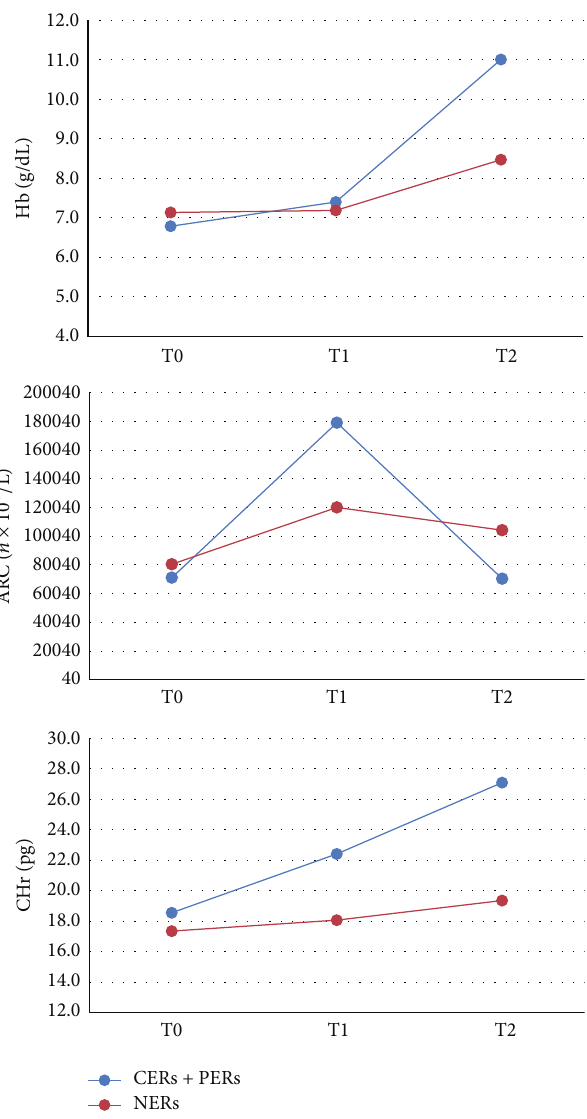
Figure 1: Trends of mean Hb, ARC, and CHr values ( 𝑦 -axis) in early responding patients (CERs + PERs) and not early responding patients (NERs) at T0: diagnosis, T1: within 7 days from the beginning of oral iron supplementation, and T2: at +30 from the onset of therapy ( 𝑥